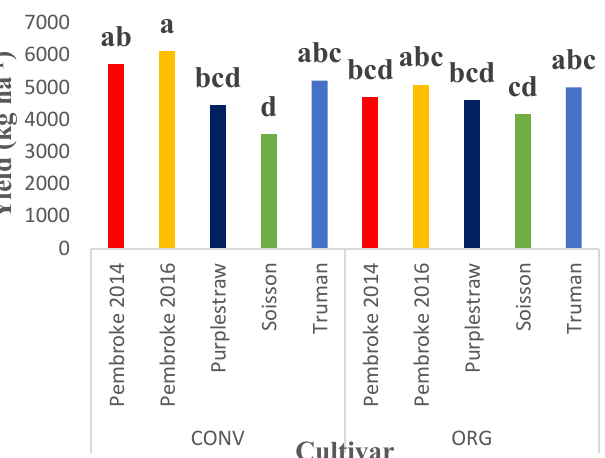
Figure 2. Soft red winter wheat yield (kg ha − 1 ) as affected by system and cultivar in Y1 ( p = 0.016). Bars with the same letters are not significantly different based on Tukey’s honest significant difference (HSD) test performed at α = 0.05. Table 3. The effect of production system and fertilizer N rate on grain yield and N content in both study years. (Same letters within each column are not significantly different based on Tukey’s honest significant difference (HSD) test performed at α =